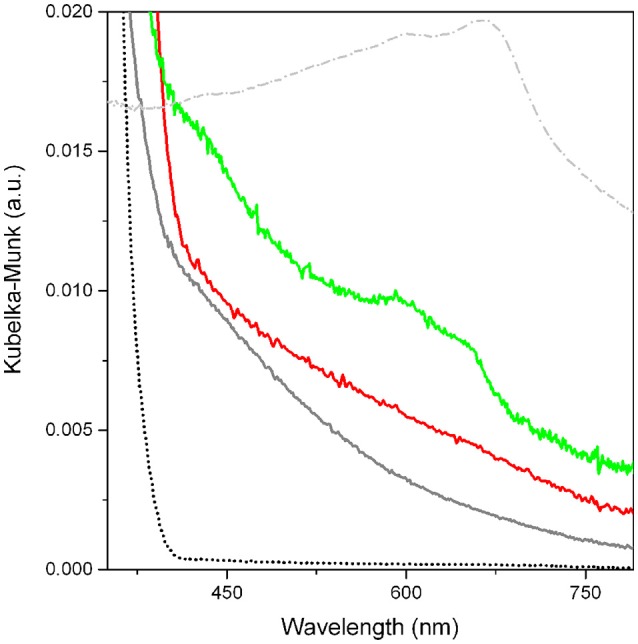
UV-vis spectra of TiO2 used as a reference (black dotted curve), p-C2H2/TiO2 (gray curve), p-C2H2/MoS2/TiO2 (red curve), MoS2/TiO2 (green curve), and MoS2 (gray dotted line).